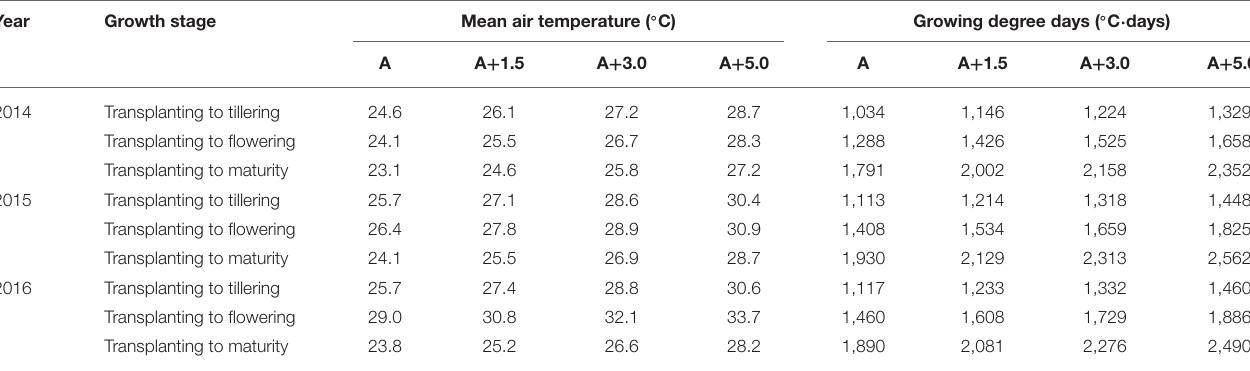
TABLE 1 | Mean air temperature during the period from transplanting (June 1) to tillering (August 10), during the period from transplanting (June 1) to flowering (August 28), and during the whole growth period (June 1 to October 15) at four sunlit temperature-controlled phytotrons adjusted to the target temperature conditions, such as ambient (A), A + 1.5 ◦ C, A + 3.0 ◦ C, and A + 5.0 ◦ C, in 2014, 2015, and